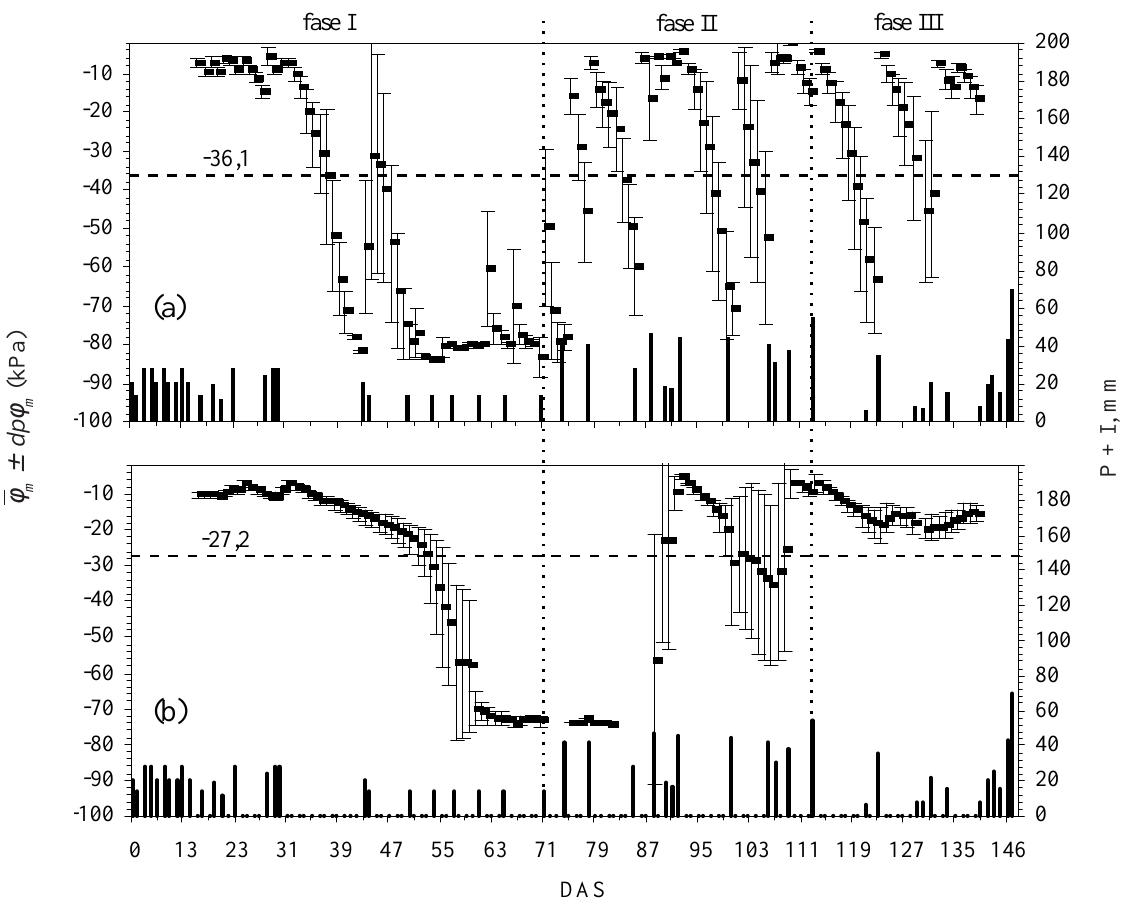
dp - barras verticais no corpo do gráfico), potencial mátrico médio diário 2. Desvios-padrões ( m f ( f m , pontos no centro das barras verticais) e médias gerais (linhas horizontais cruzando o gráfico), em kPa, e lâminas de água precipitada ou irrigada (P + I, mm), ao longo do tempo (DAS, dias após a semeadura): tratamento tr0I0, (a) 0,10 m e (b) 0,80 m de